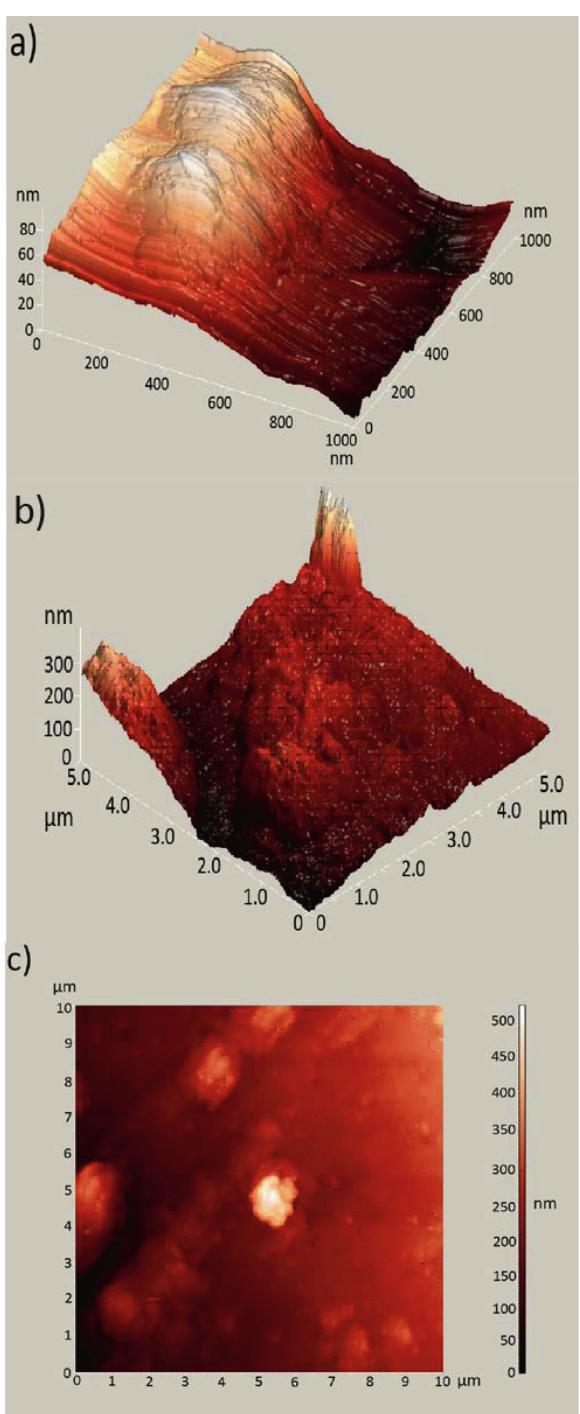
Figure 3. Topographic AFM plots of ABS/CdS-or (a, b) three dimensional and (c) two dimensional.